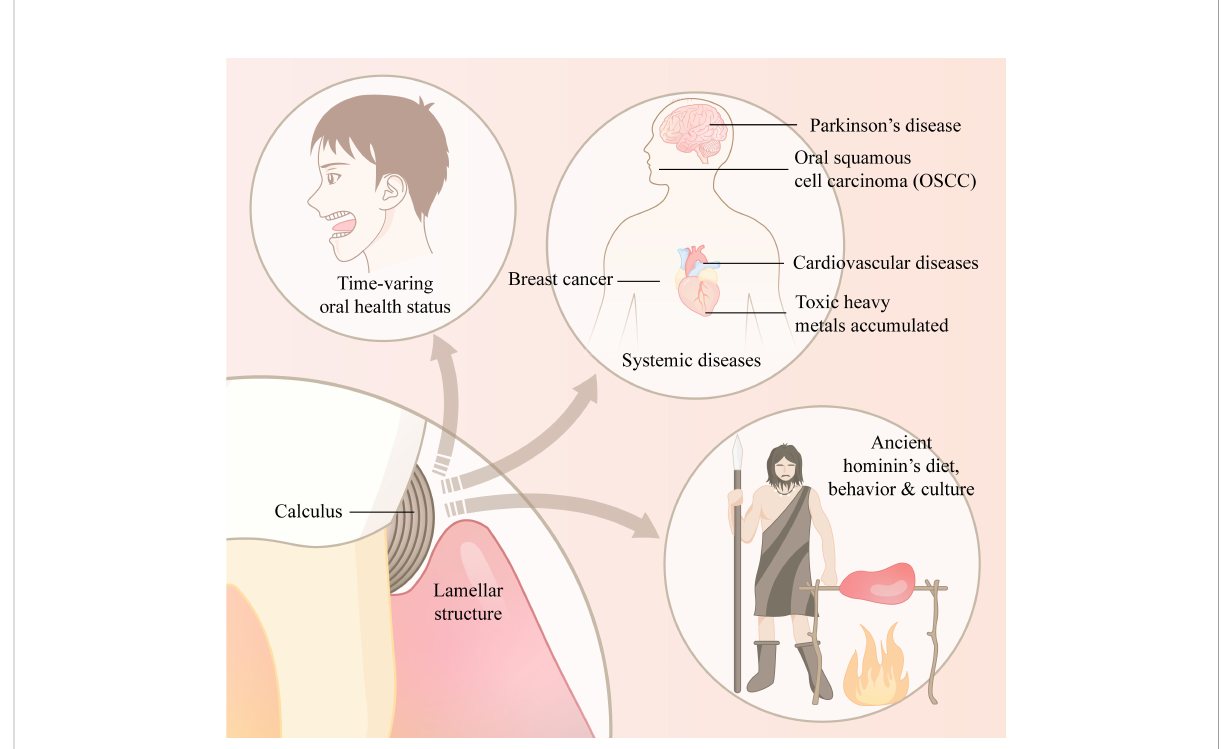
FIGURE 2 The summary of biological information hidden in absorbates of dental